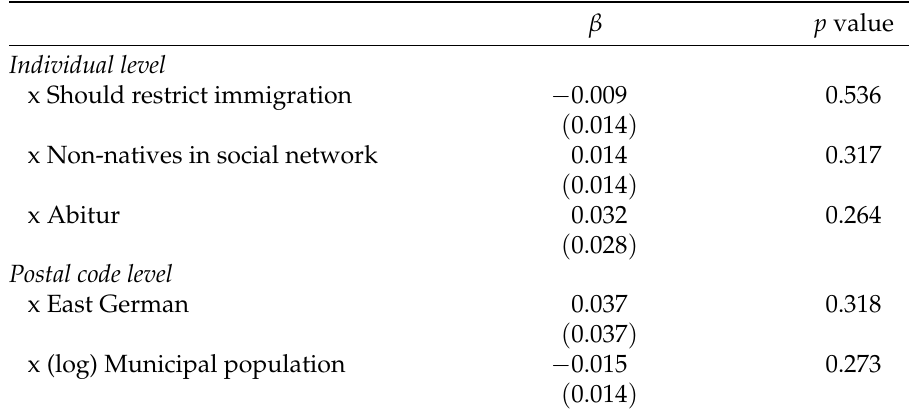
Table 1: Interaction coefficients of the treatment with respondent characteristics